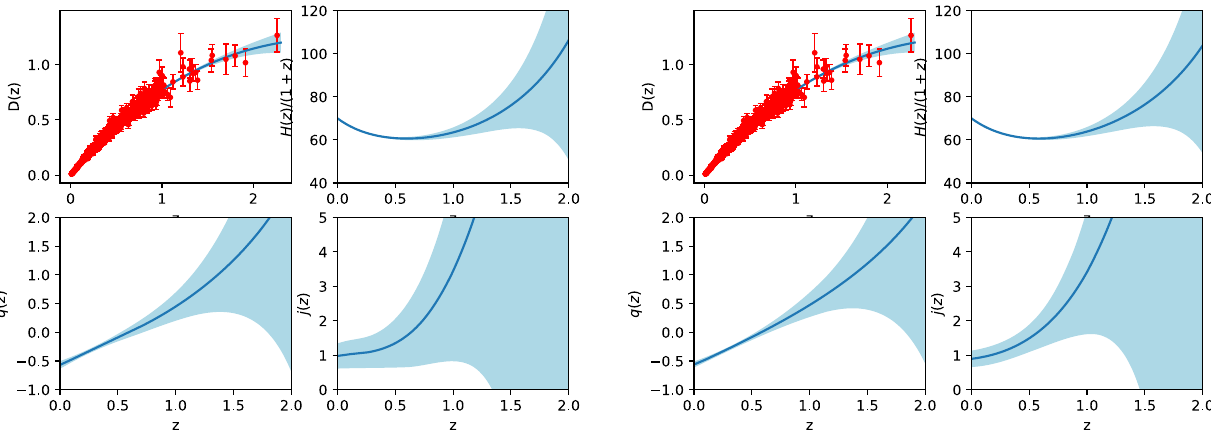
Fig. 1 Left panel: Reconstruction of D ( z ) , data points and its first, second and third derivatives. Right panel: Reconstruction of D ( z ) , the Hubble function, deceleration and jerk parameters as a function of redshift for SNIa data only with the Gaussian kernel